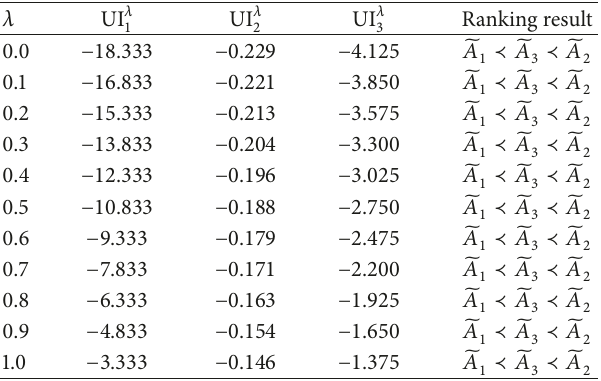
Table 7: Ranking results of the three fuzzy numbers in Example 20.